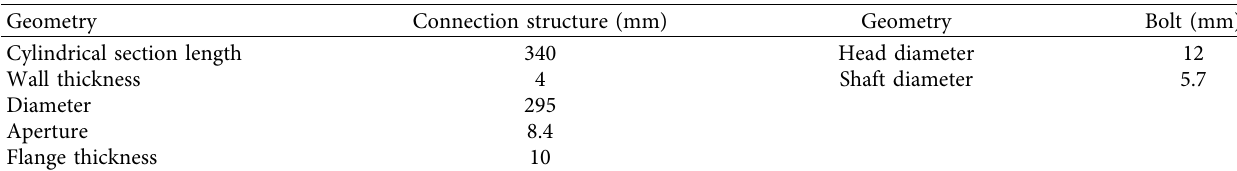
Table 2: Connection structure geometry